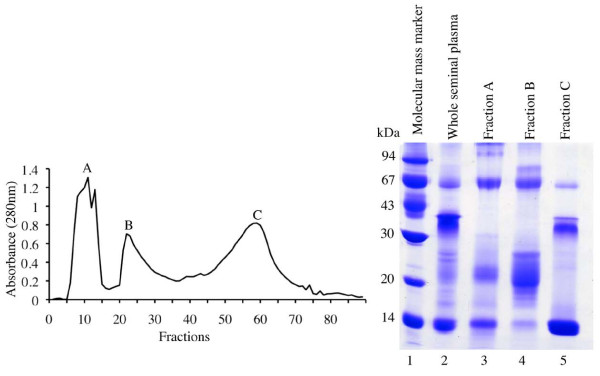
Protein fractions of llama seminal plasma. Fractions A, B and C were eluted on hydroxylapatite gravity chromatography columns using a lineal gradient of 10 to 400 mM sodium phosphate (left). Fraction C contained a major 14 kDa protein observed after denaturing on 12% SDS-PAGE (right).